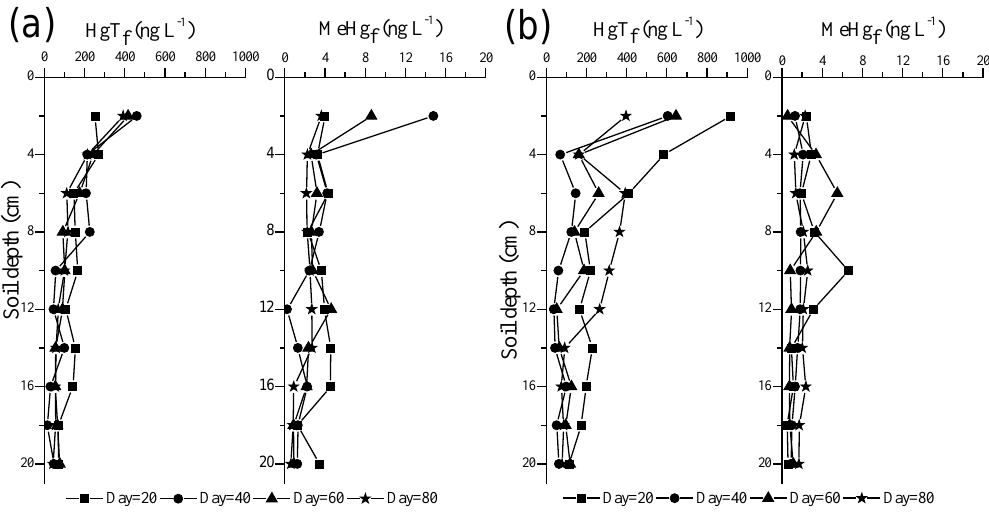
Figure 2. Concentration of HgT f and MeHg f (ngL − 1 ) in pore water during the rice growing season on Days 20, 40, 60, and 80: ( a ) artisanal Hg mining site of Gouxi; (b) abandoned Hg mining site of Wukeng.